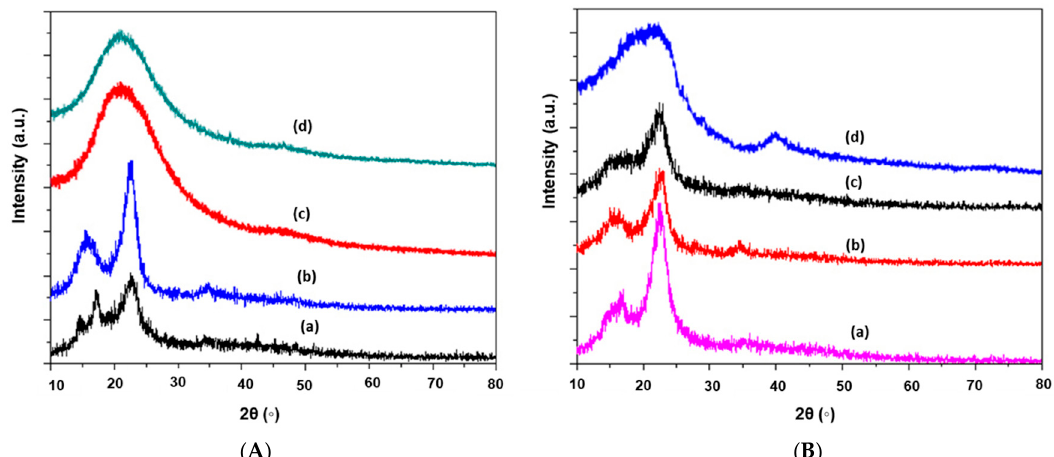
Figure 6. ( A ) X-ray Spectra of Dimocarpus longan peel powder (LFP) and the corresponding carbon micro-spheres produced at various temperatures: ( a ) LFP Powder, ( b ) LFP-200, ( c ) LFP-250, and ( d ) LFP-300 produced at various temperatures. ( B ) X-ray Spectra of HC and their corresponding carbon micro-spheres produced at various temperatures: ( a ) HC, ( b ) HC-200, ( c ) HC-250, and ( d ) HC-300.